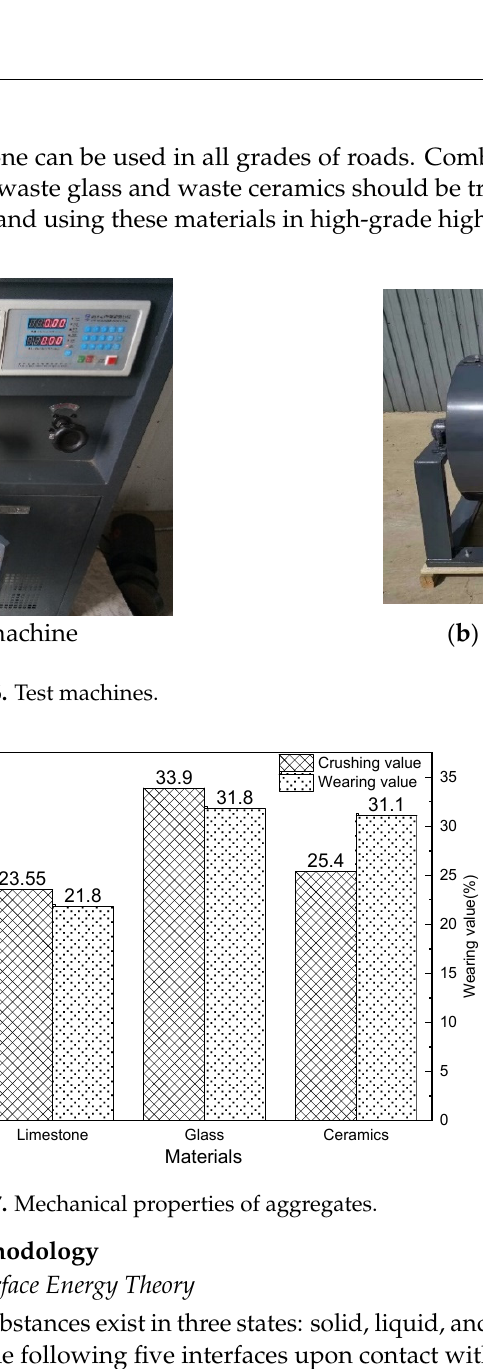
Figure 7. Mechanical properties of aggregates. Table 3. Local standards of mechanical properties.